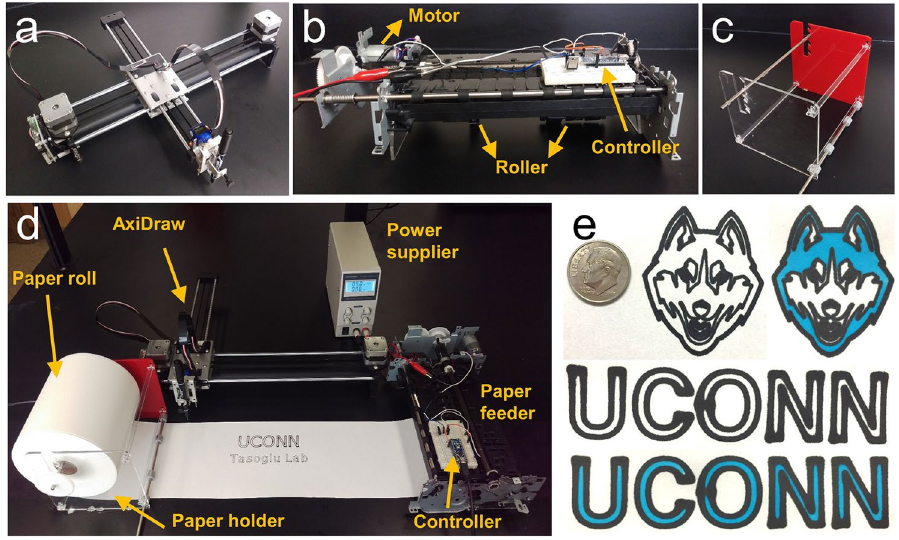
Figure 1. High-throughput rapid-prototyping of low-cost paper-based microfluidics. ( a ) Desktop pen plotter and ( b ) a customized paper feeder. ( c ) Holder of paper roll manufactured with a laser cutter. ( d ) Plotter integrated with the feeder. ( e ) Sample patterns plotted by desktop pen plotter and colored by liquid fabric